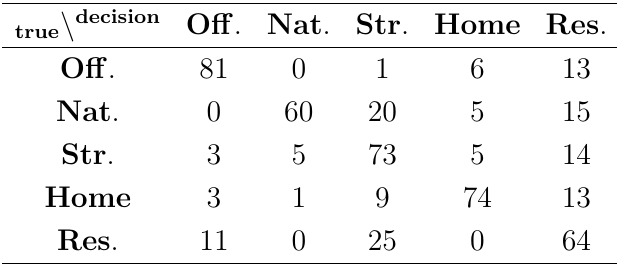
Table 12. Confusion matrix of five environment classes office , nature , street/road , home and restaurant/pub/cafe after